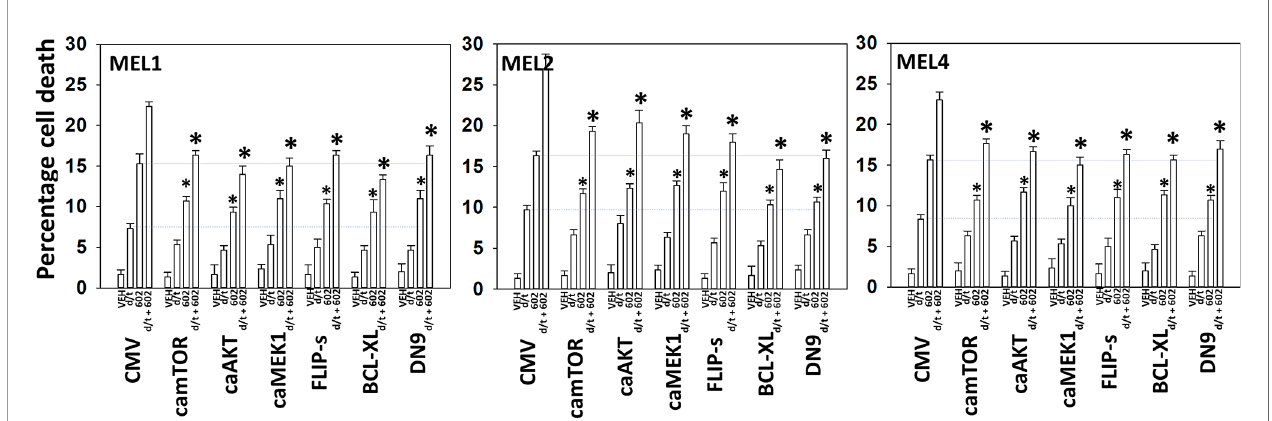
FIGURE 8 | Enhanced tumor cell killing by [GZ17-6.02 + trametinib + dabrafenib] requires mitochondrial dysfunction. Cells were transfected with an empty vector plasmid (CMV) or with plasmids to express the indicated proteins. Twenty-four h later, cells were treated with vehicle control, GZ17-6.02 [curcumin (2 µM) + isovanillin (37.2 µM) + harmine (4.5 µM)], [trametinib (t, 2 µM) + dabrafenib (d, 2 µM)] or the drugs in combination for 24h. Cells were isolated and viability determined by trypan blue exclusion (n = 3 +/- SD). *p < 0.05 less than corresponding value in siSCR transfected